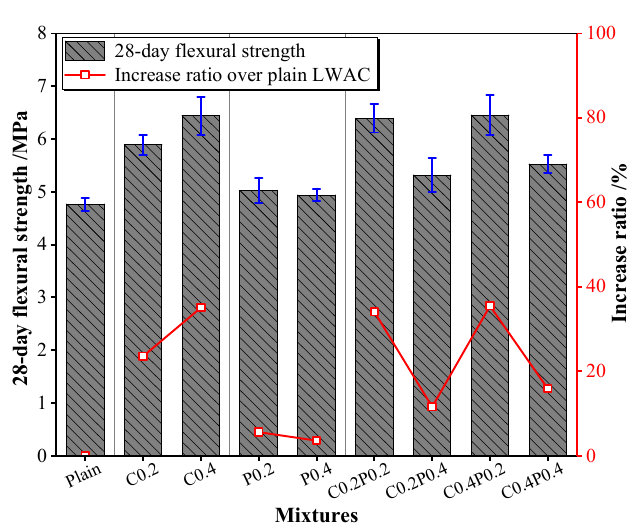
Figure 9. The splitting tensile strength of LWAC.